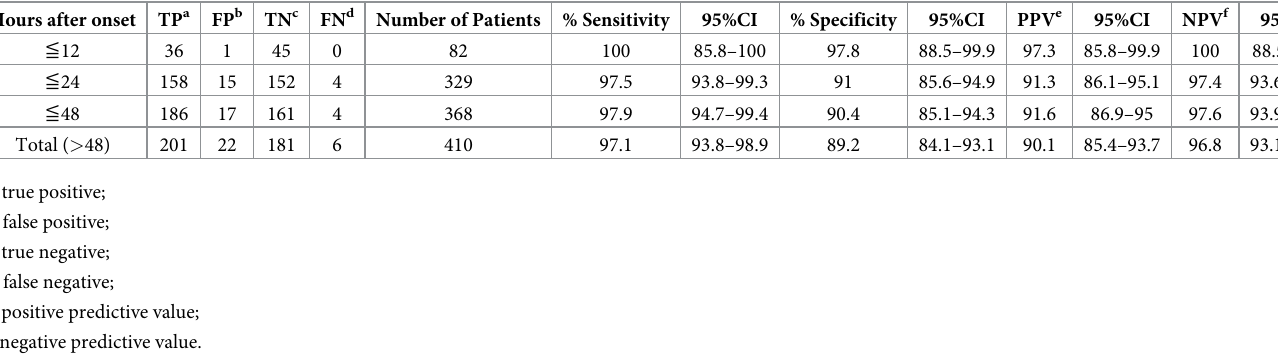
negative predictive value.